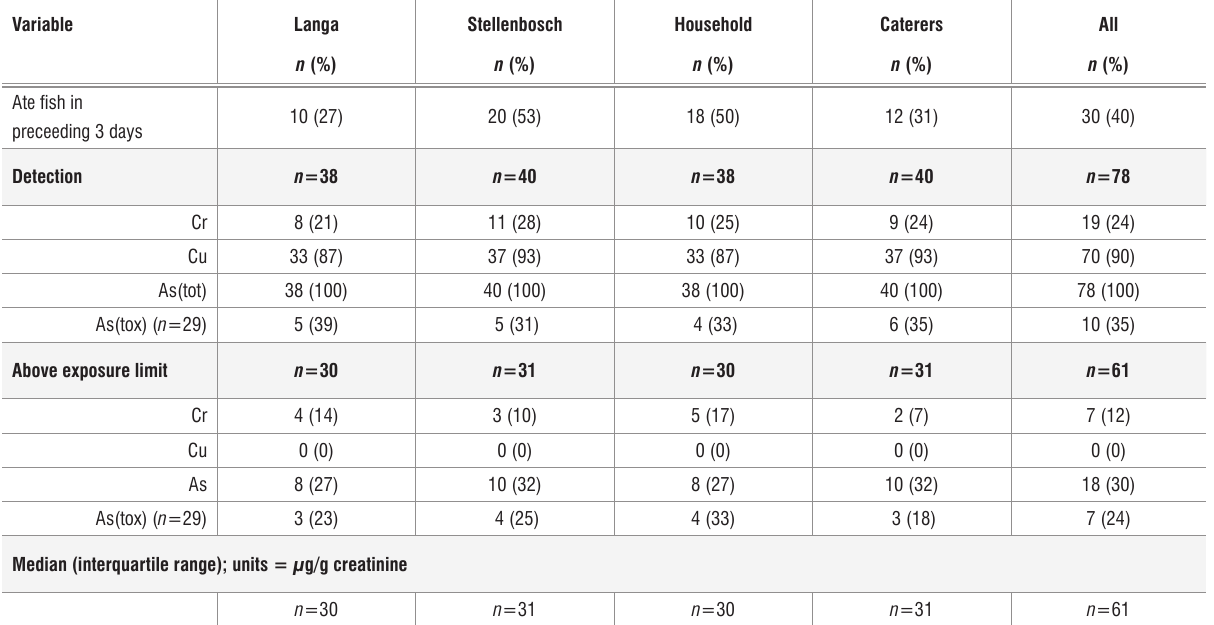
Table 4: Comparison of urinary Cr, Cu and As between area and caterers/household residents